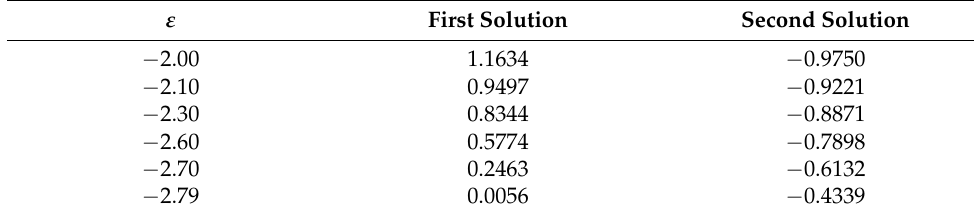
Table 4. Results of the smallest eigenvalues ω 1 by several ε